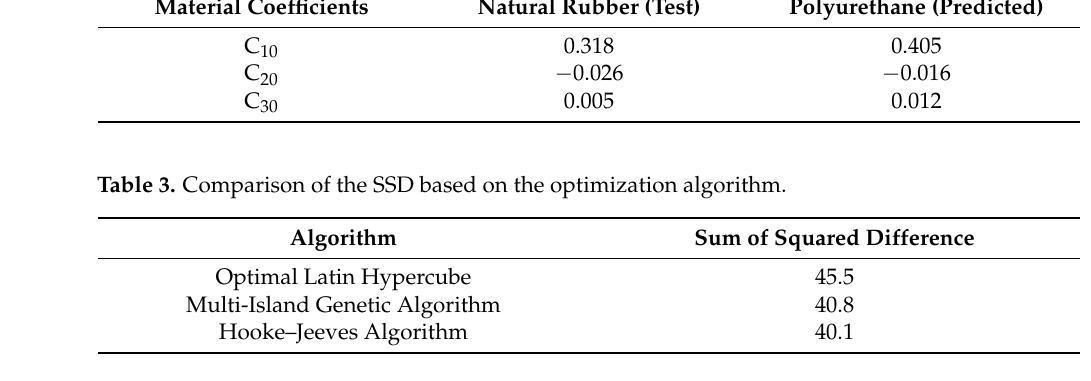
Figure 7. Optimization histories of sum of squared difference using HJA: ( a ) optimization history; ( b ) detailed view of optimization history. Table 2. Comparison of material coefficients of natural rubber (test) and polyurethane (predicted).